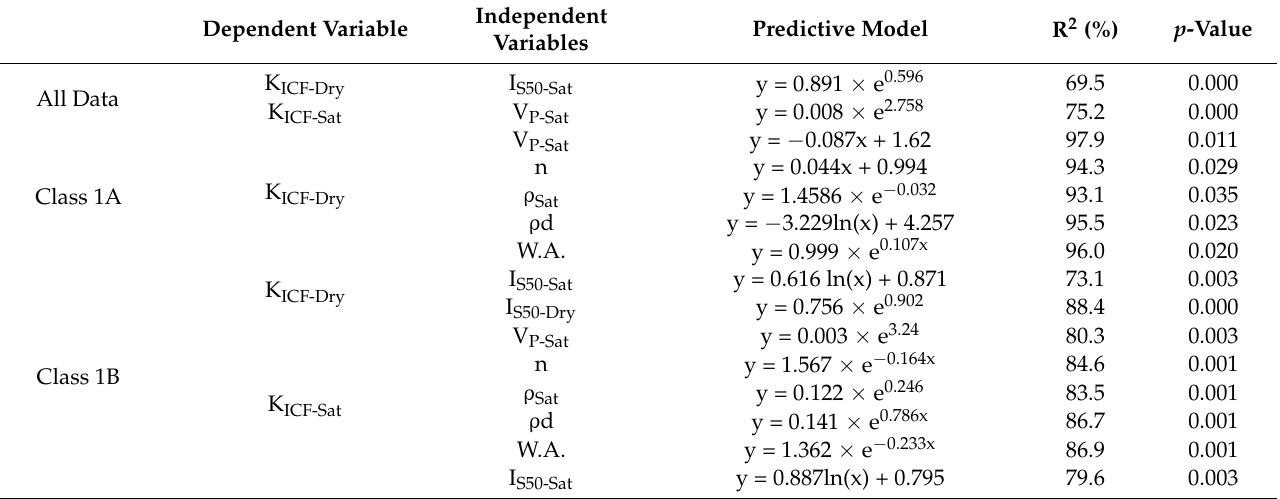
Table 8. Statistical parameters of the simple linear/nonlinear regression between K IC and the index